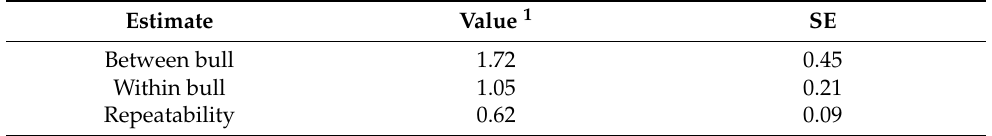
Table 4. Estimated repeatability of bull prolificacy and component variances.